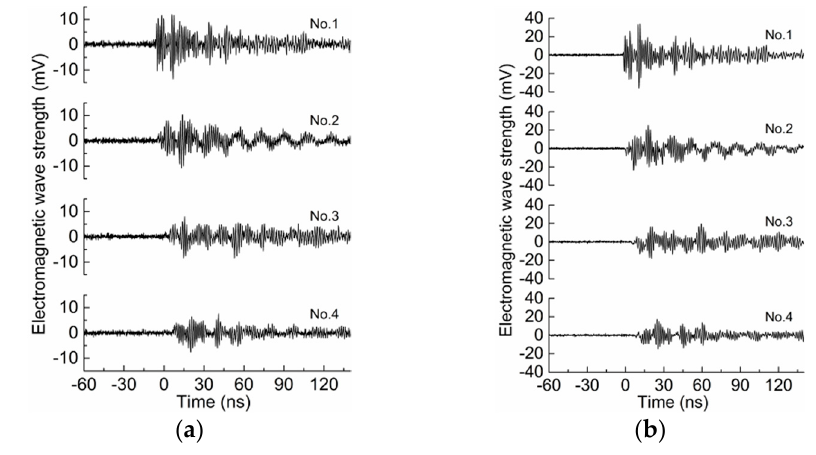
Figure 5. Time domain waveforms of UHF signals induced by protrusion defect ( θ = 0°, DS closed). ( a ) U = 6.5 kV; ( b ) U = 9.6 kV.